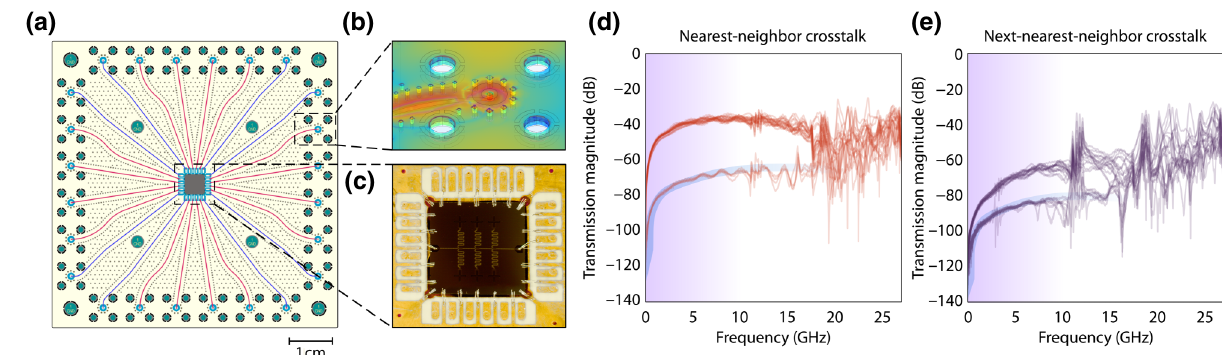
FIG. 2. Interposer design. (a) Interposer layout for a 24-line package fabricated out of a three-layer Rogers 4350 controlled impedance glass-reinforced ceramic laminate. Stripline-based waveguides with dense via shielding are utilized to reduce signal crosstalk. (b) EM simulation [three-dimensional (3D) finite element simulation software COMSOL Multiphysics] of a via transition used for subminiature push-on- (SMP) type microwave connectors. The transition is impedance matched (not shown) to minimize reflections and effects on the step response. (c) Picture of a 5 × 5 mm 2 qubit chip mount with signal launches in the periphery. Wire- bonds are used to provide signal connections and ground the device. (d),(e) Measured nearest-neighbor and next-nearest-neighbor crosstalk. A high-port count network analyzer using Keysight M9374A PXIe modules is used to obtain the full scattering matrix. All transmission parameters corresponding to signal crosstalk information are overlaid on the plots. The purple background fading out with increasing frequency indicates the decreasing relevance of modes as their frequency separation to the qubit transition frequency increases. Note that the separate group of traces with greater isolation, as highlighted in (d),(e), correspond to crosstalk that is reduced at corners of the package, as indicated by the pairs of blue lines in